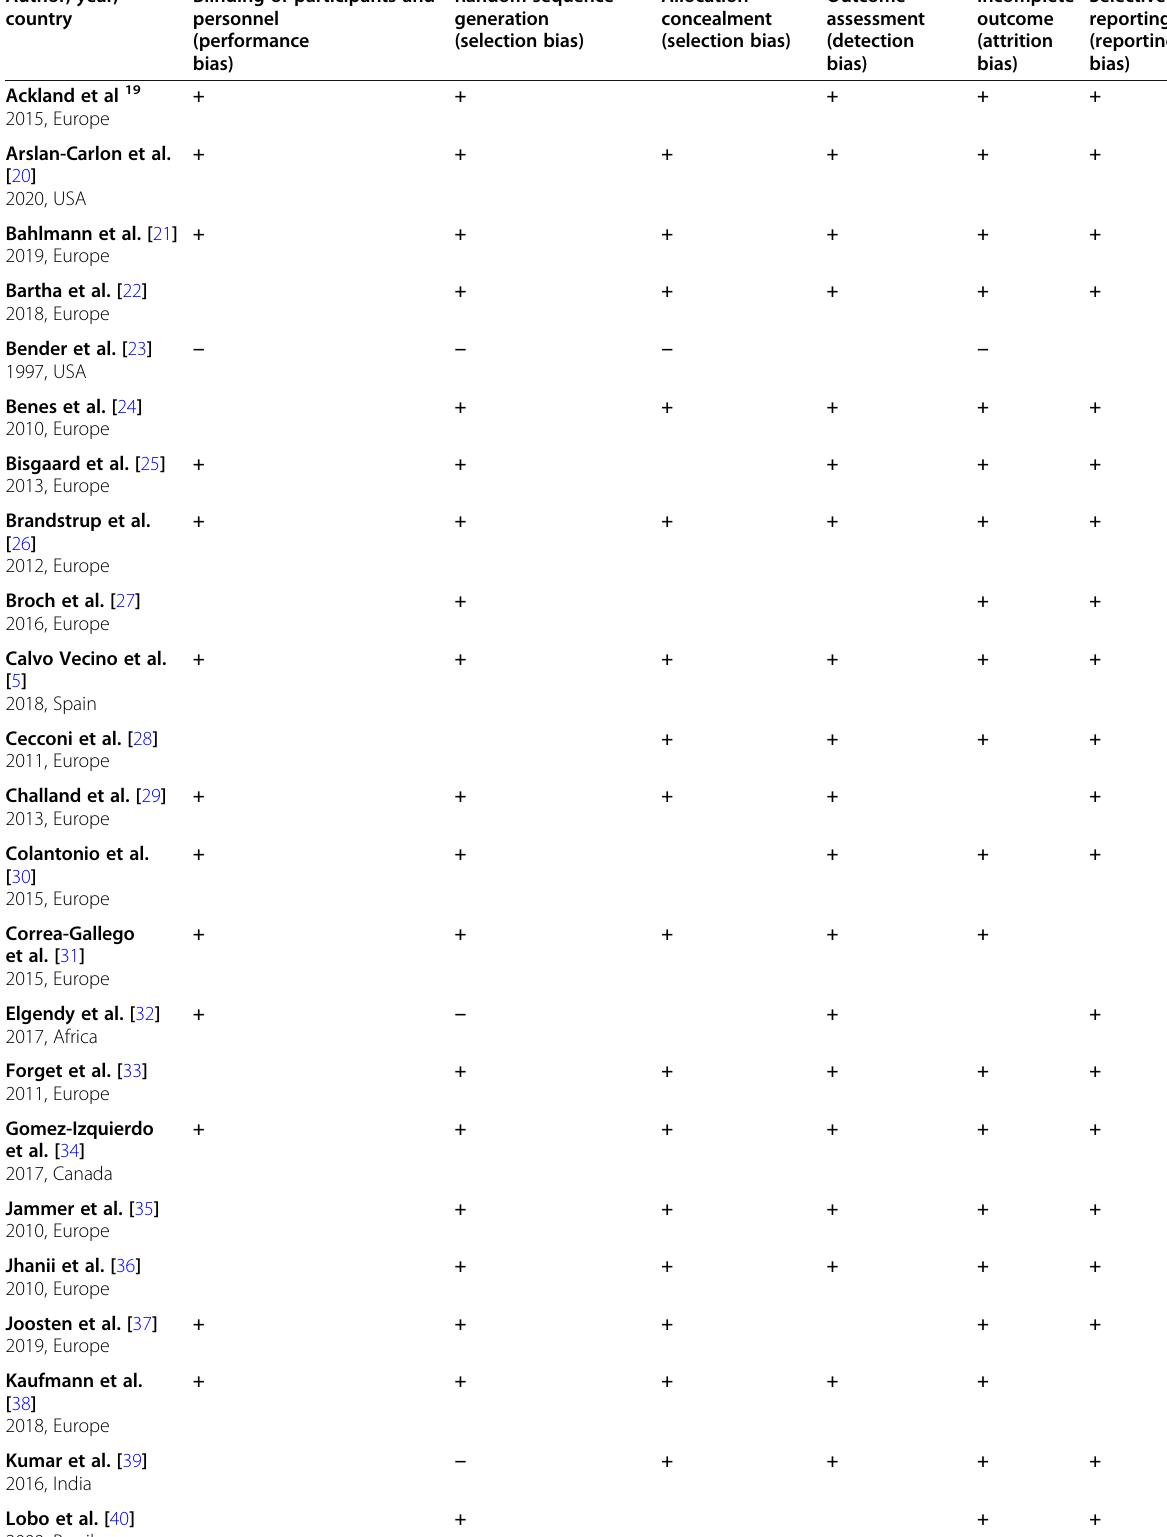
Table 2 The risk of bias assessment for each trial, according to the Cochrane domain-based evaluation Author, year,